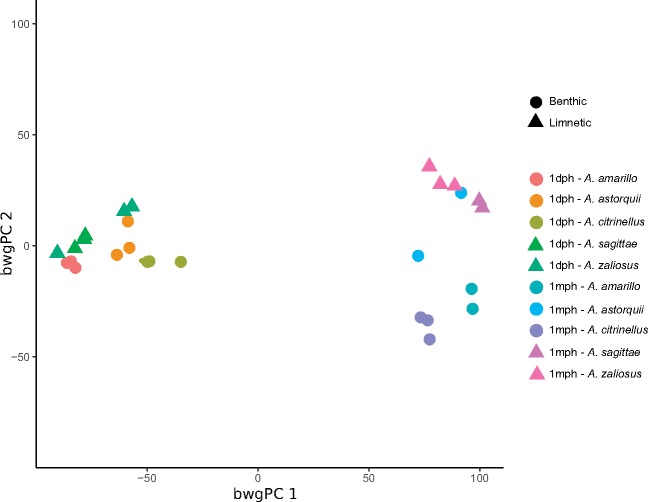
—Scores along the first two between-group principal components (bwgPC) obtained using each individual combination of stage (1 dph and 1 mph) and morph (benthic and limnetic) as factor.